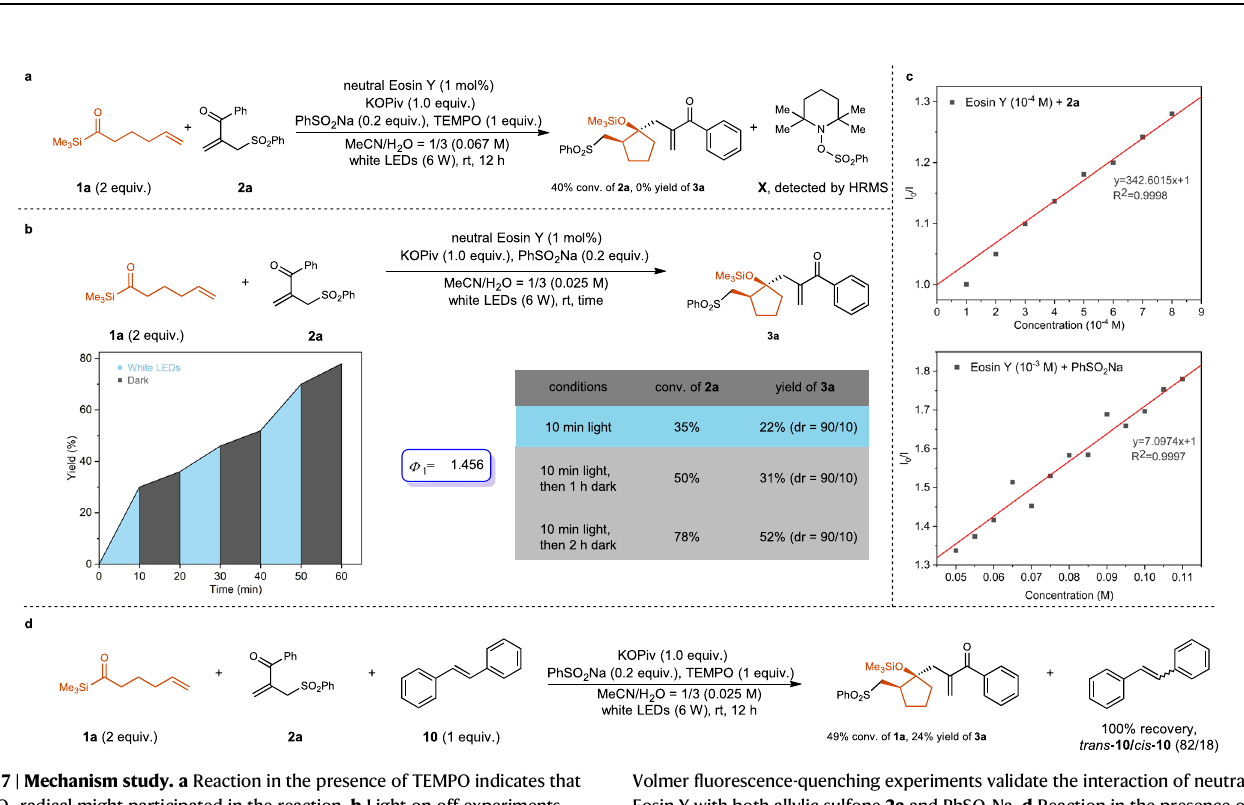
Fig. 7 | Mechanism study. a Reaction in the presence of TEMPO indicates that PhSO 2 radical might participated in the reaction. b Light on-off experiments, determination of quantum yield and light-darkness control experiment support that the reaction might proceed through radical chain mechanism. c Eosin Y emissionquenchingby 2a andEosinYemissionquenchingbyPhSO 2 Na.TheStern-